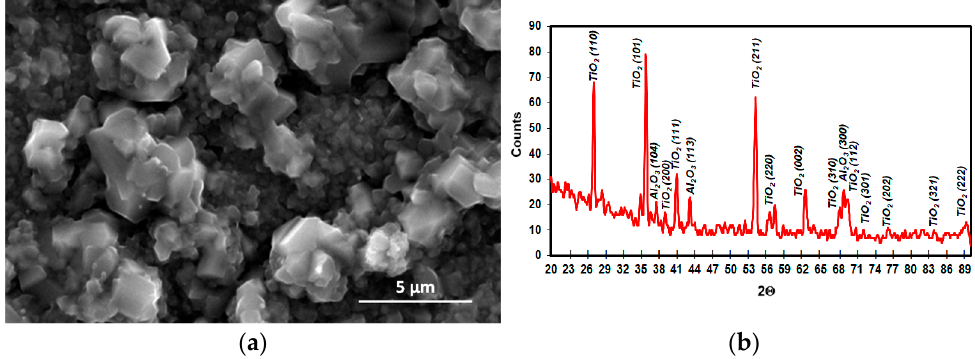
Figure 6. Surface of Ti-46Al-7Nb-0.7Cr-0.1Si-0.2Ni alloy exposed to air at 875 °C: ( a ) SEM micrograph—surface prepared by grinding [26]; ( b ) XRD microanalysis result—small columnar crystallites of TiO 2 .